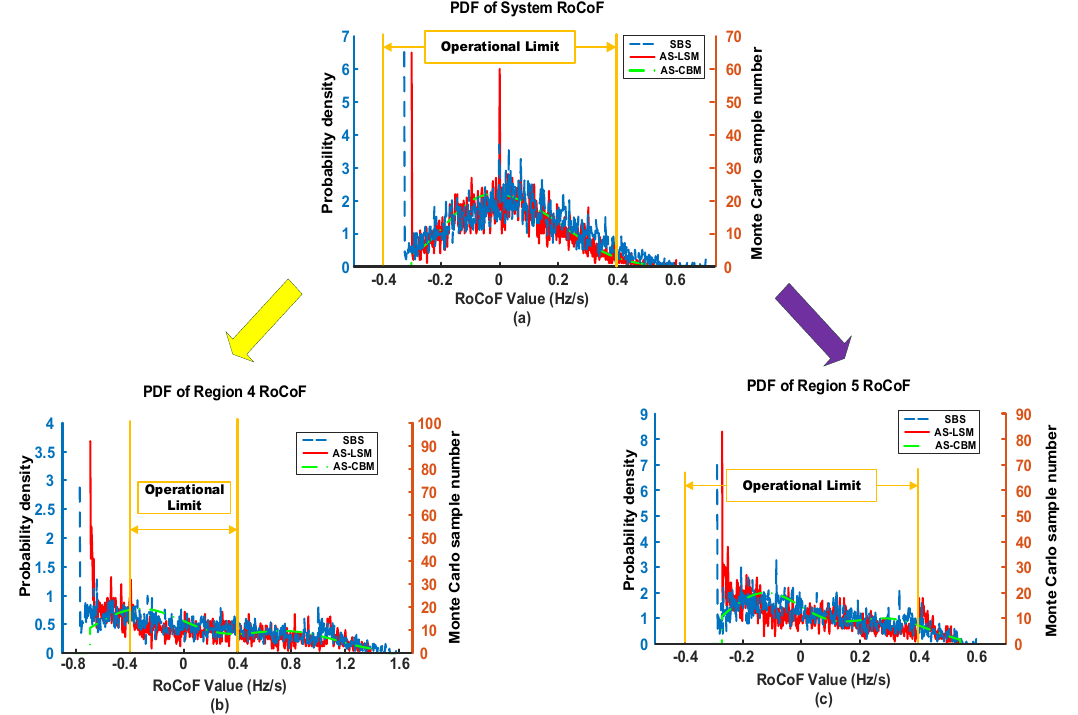
Figure 5. Probabilistic density functions (PDFs) of system/regional RoCoF by scenario-based simulation (SBS), AS-LSM, and analytical sensitivity-cumulant-based method (AS-CBM); ( a ) system, ( b ) Region 4, and ( c ) Region 5. Table 2. Probabilistic distribution of the system, region 4, and region 5 RoCoF using SBS, AS-LSM, and AS-CBM within operational limits (uncorrelated wind speed).